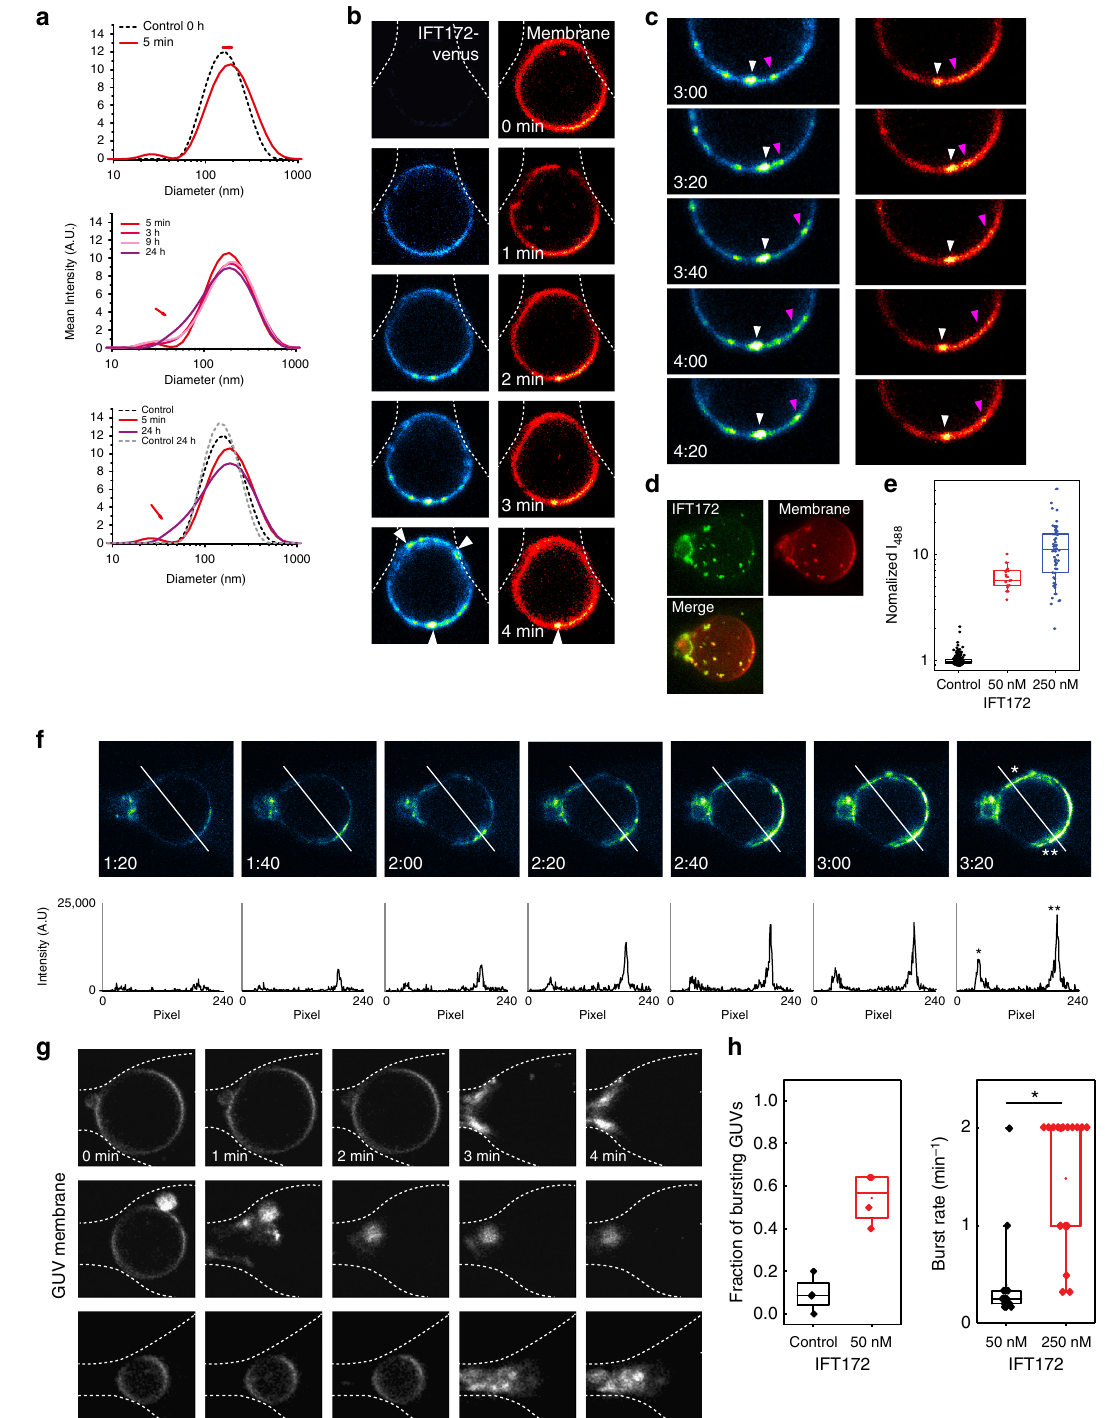
tary Figure 3A). The fraction of ring-like structures (Supplemen- tary Figure 3B) shifted to longer elution times and mass spectrometry con fi rmed that it contained both lipids and IFT172. (Supplementary Figure 3C and